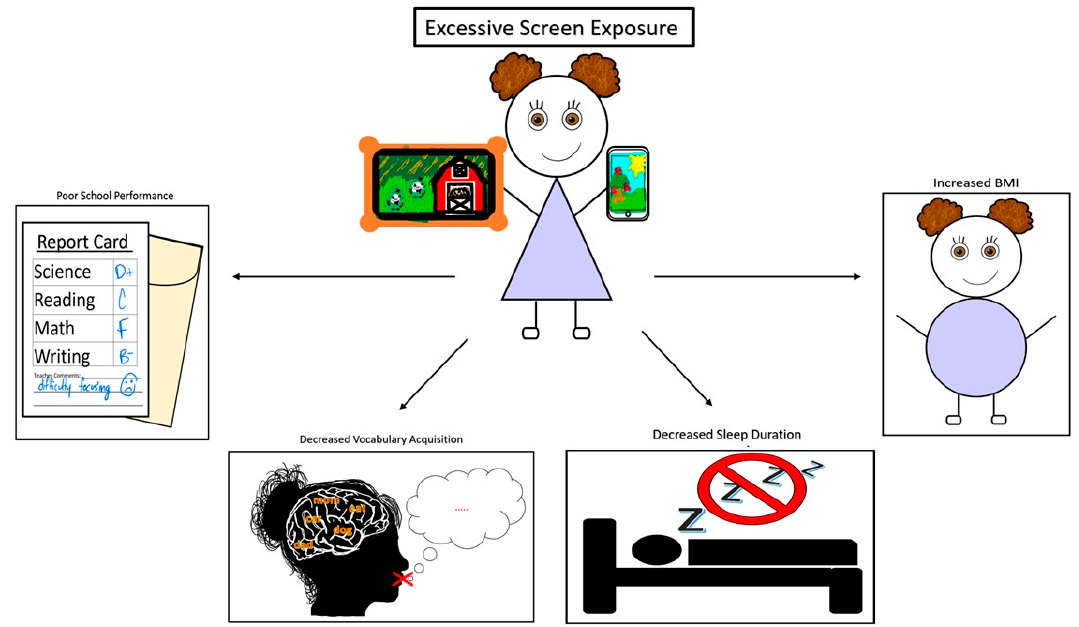
Figure 2. Effects of excessive screen exposure.